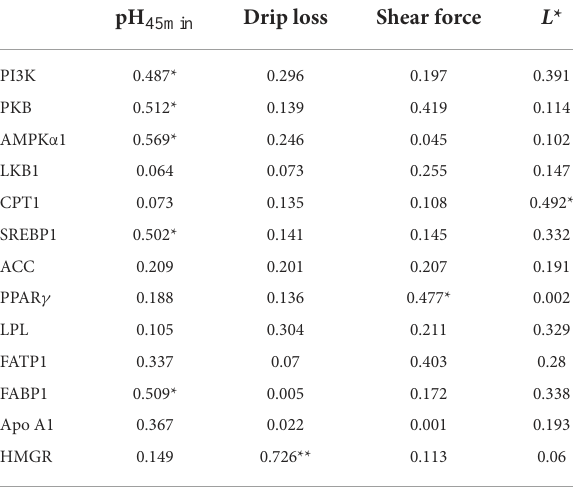
TABLE 6 Correlation between chicken quality and PI3K/PKB/AMPK signaling